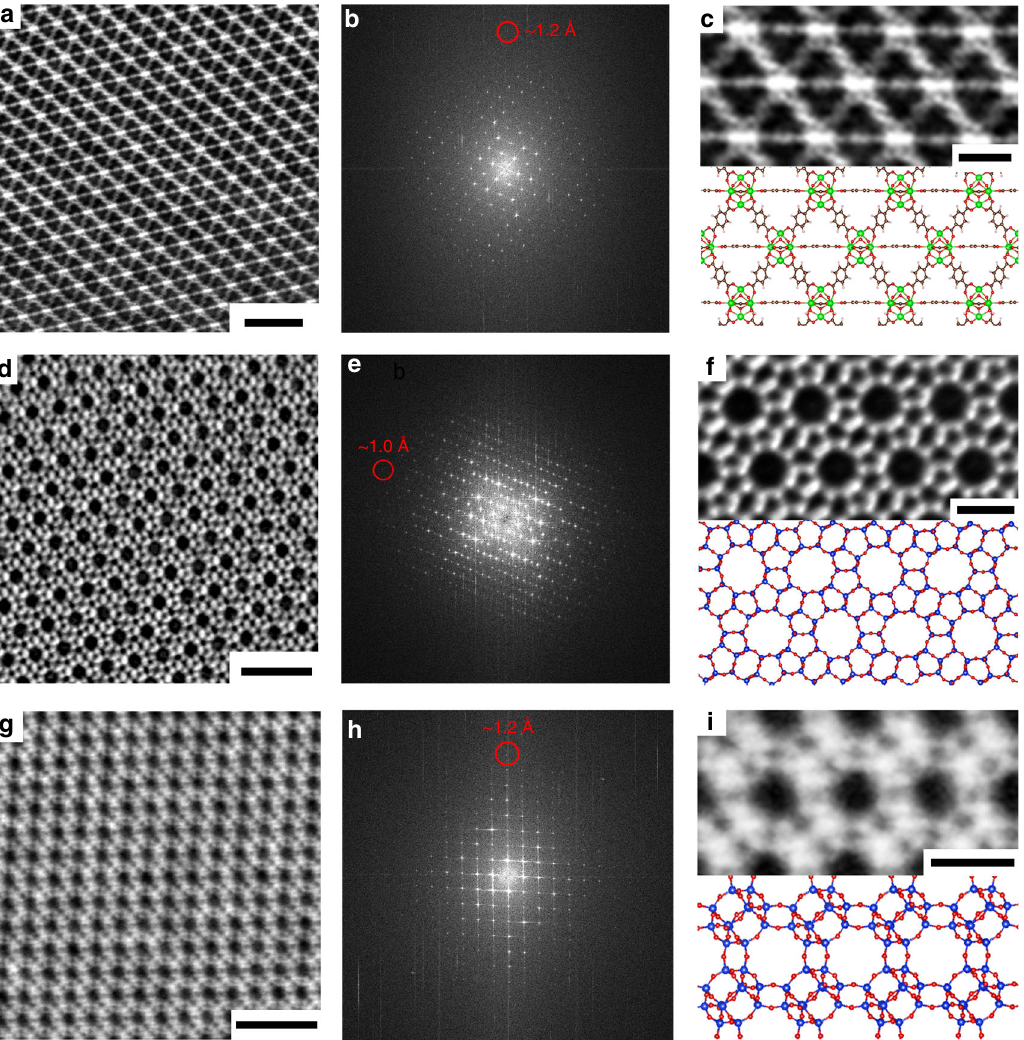
Fig. 5 The iDPC-STEM imaging of other beam-sensitive materials. a The iDPC-STEM image of UiO-66 framework from the <110> projection. Scale bar, 3 nm. b The FFT pattern corresponding to a showing an information transfer of ~1.2 Å. c The magni fi ed image of a compared with the structural model. Scale bar, 1 nm. d The iDPC-STEM image of ZSM-5 framework from the <010> projection. Scale bar, 3 nm. e The FFT pattern corresponding to d showing an information transfer of ~1 Å. f The magni fi ed image of d compared with the structural model. Scale bar, 1 nm. g The iDPC-STEM image of SAPO-34 framework from the <1 -1 -1> projection. Scale bar, 3 nm. h The FFT pattern corresponding to g showing an information transfer of ~1.2 Å. i The magni fi ed ima g e of g compared with the structural model. Scale bar, 1